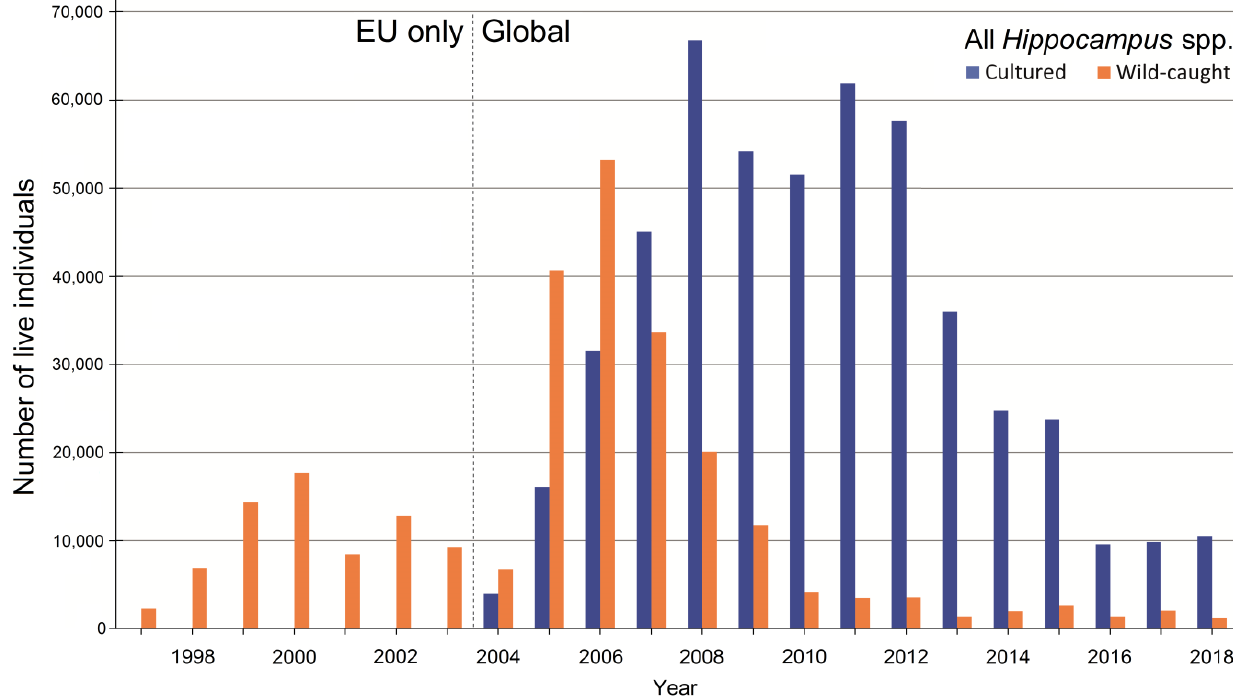
Figure 5. International trade in cultured (C + F) and wild-caught (W + U) Hippocampus specimens based on CITES import data for the period 1997–2018 [69]. Data from before 2004 concern the EU only.